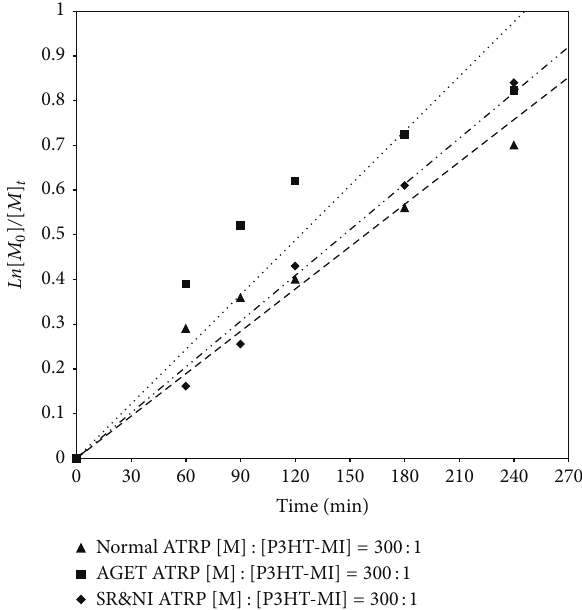
Figure 11: Kinetic plots of 𝐿𝑛[𝑀 0 ]/[𝑀] versus time for polymerisa- tionofstyreneandCMSviadifferentATRPsystems,usingtheP3HT macroinitator (monomers/macroinitiator mole ratio = 300 : 1).